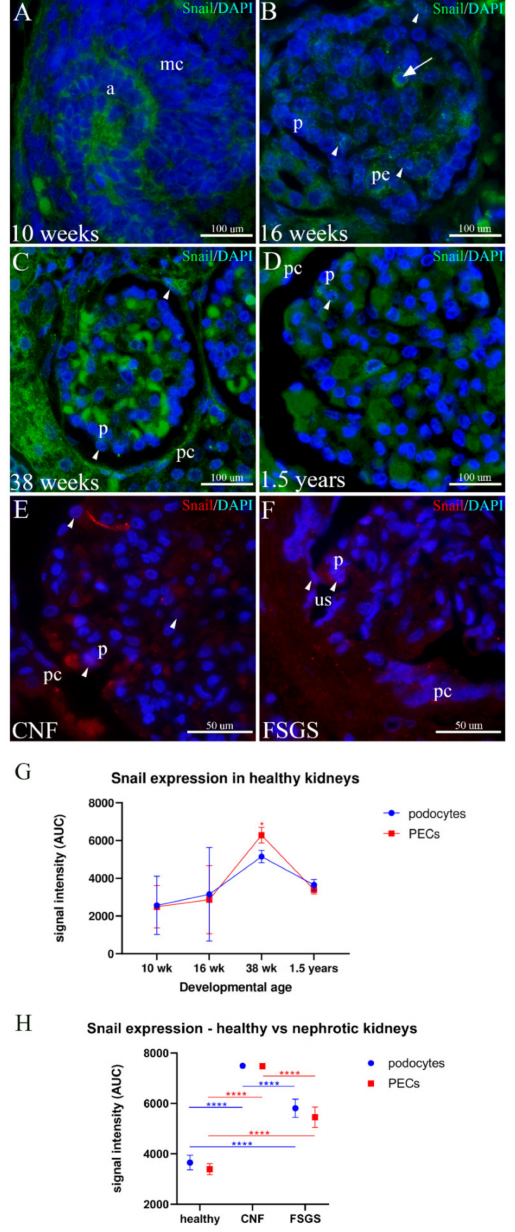
Figure 6. Expression of Snail in the developing podocytes and PECs in healthy postnatal and CNF and FSGS kidneys; metanephric cup (mc), ampulla (a), podocytes (p), PECs (pc), peripolar cells (pe), urinary space (us). ( A ) 10th developmental week; Snail expression is seen in the metanephric cup and ampulla of the collecting system. ( B ) 16th developmental week; moderate cytoplasmatic expression of Snail characterizes some centrally positioned glomerular cells (arrow), whereas some PECs and peripolar cells show nuclear Snail expression (arrowheads). ( C ) 38th developmental week; nuclear expression of Snail can be observed in some podocytes and PECs (arrowheads). ( D ) Postnatal healthy kidneys; weak nuclear Snail expression is present in some glomerular cells (arrowhead). ( E ) CNF kidneys; nuclear Snail expression can be found in some podocytes and glomerular cells (arrowheads). ( F ) FSGS kidneys; nuclear expression of Snail is observed in some podocytes and PECs that form bridges over the urinary space (arrowheads). ( G ) Overall expression pattern of Snail in the podocytes and PECs of healthy developing kidneys. ( H ) Comparison in the expression pattern between healthy and CNF and FSGS kidneys shows significant differences in both cell types. Error bars show SD. * p < 0.05; **** p <